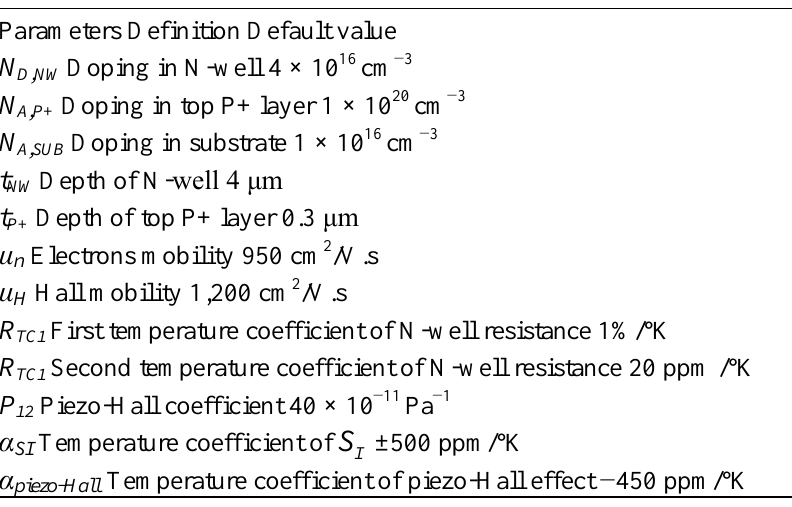
Table 1. Model parameters (using AMS 0.8 μm CMOS process)